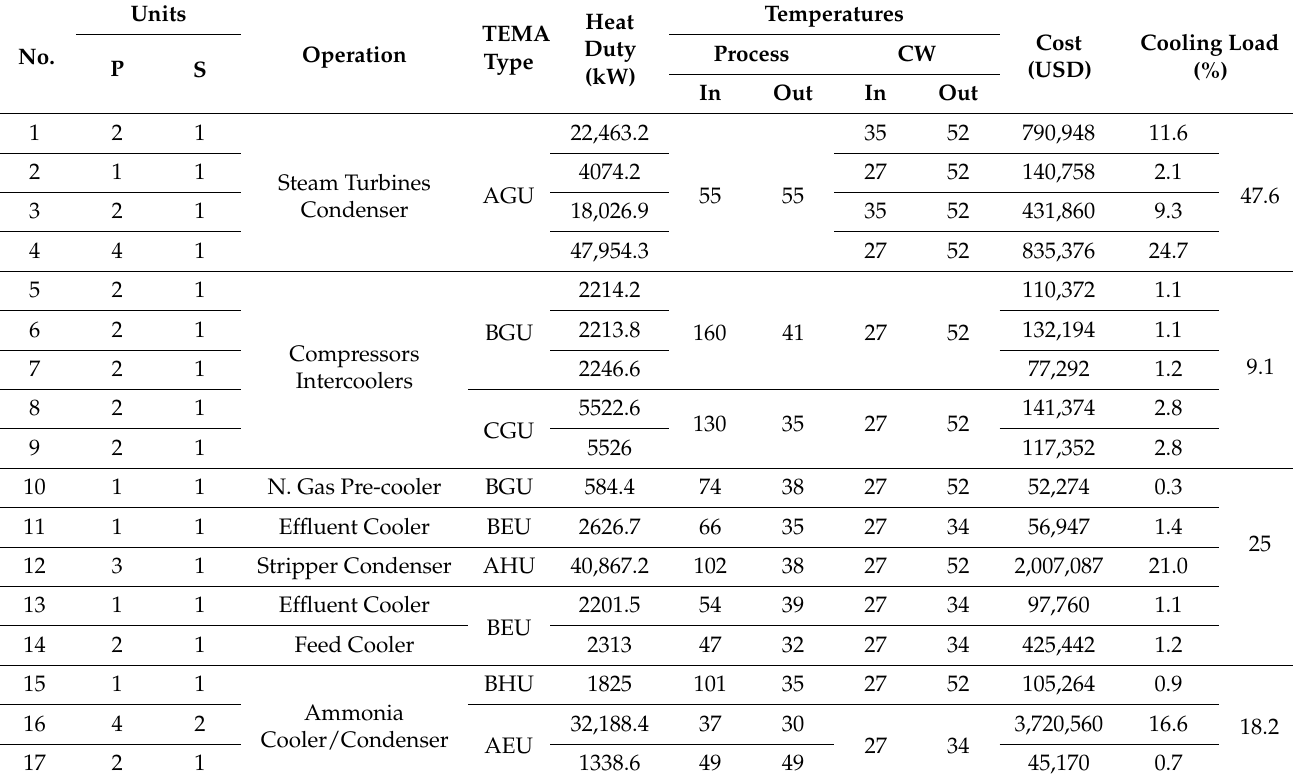
Table 5. Process coolers design and